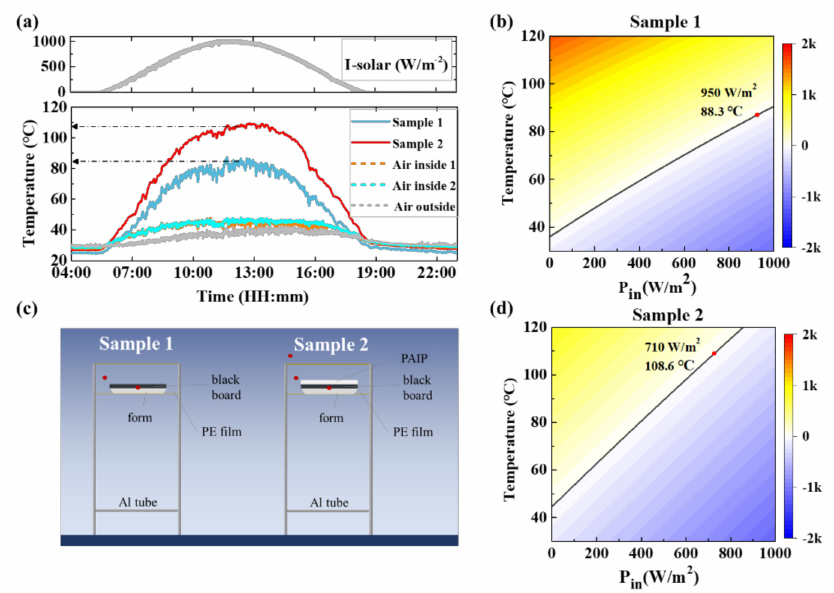
Figure 4. Outdoor test results. ( a ) Solar radiation intensity and temperature of samples. ( b ) Temperature simulation result of sample 1 under di ff erent input power. ( c ) Device setup of outdoor heat conversion test. ( d ) Temperature simulation result of sample 2 under di ff erent input